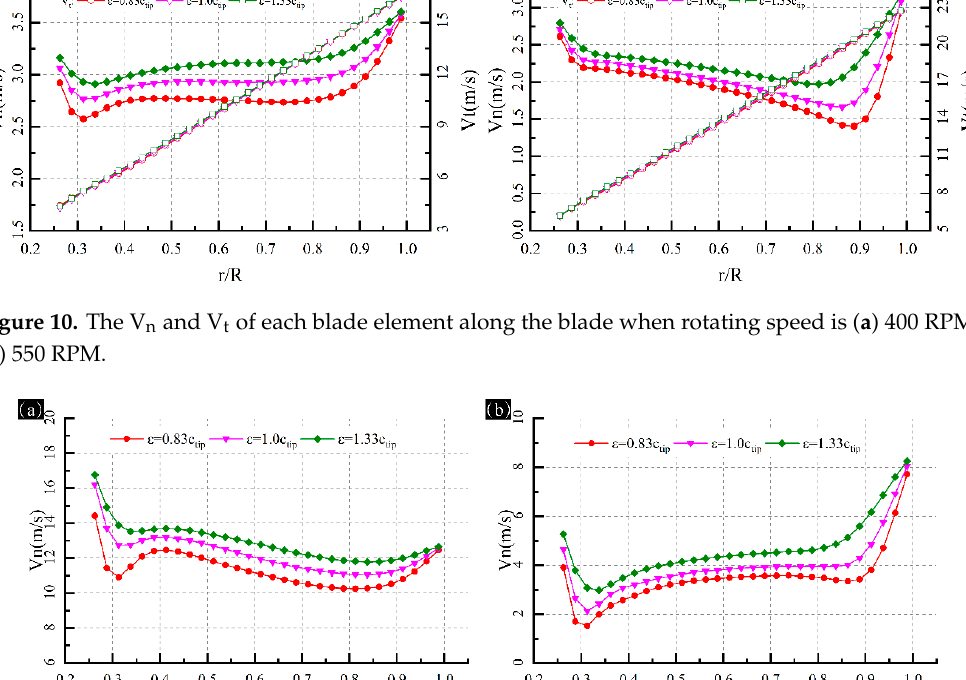
Figure 11. The attack angle of each blade element along the blade when rotating speed is ( a ) 400 RPM, ( b ) 550 RPM.